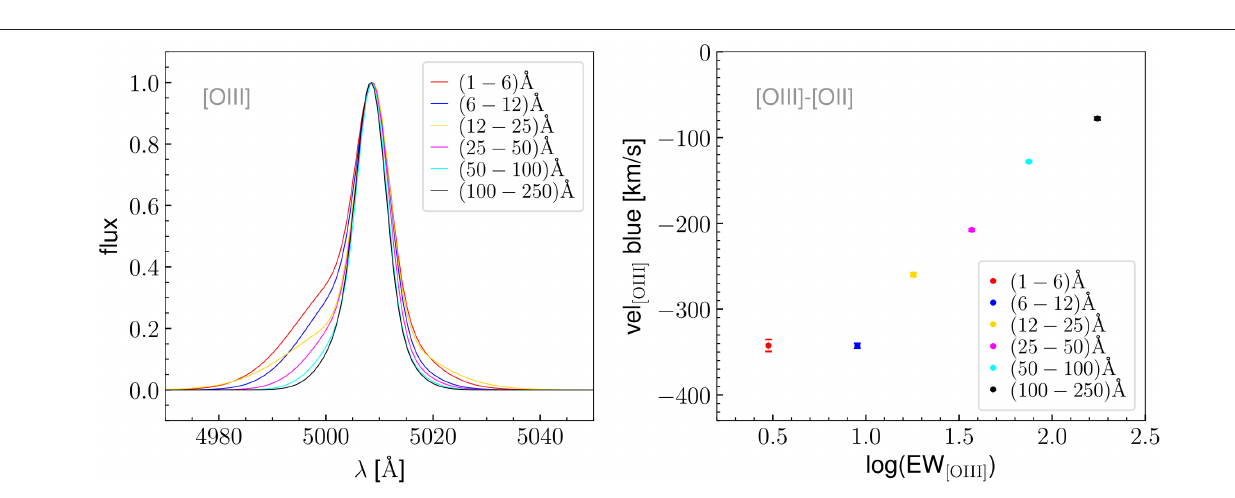
FIGURE 2 | Left: [OIII] 5007Å line profile as a function of EW[OIII]. The blue component of the line decreases moving from low to high EW[OIII]. Right: velocity shift of the blue component of the [OIII] line with respect to the velocity of the [OII] λ 3727 line, accounting for the systemic velocity of the host galaxy. The shift is decreasing (in modulus) when moving from low to high EW[OIII]. Both the trends are expected if we are moving from face-on to edge-on positions, where the outflow velocity component of the gas is not intercepted anymore by the line of